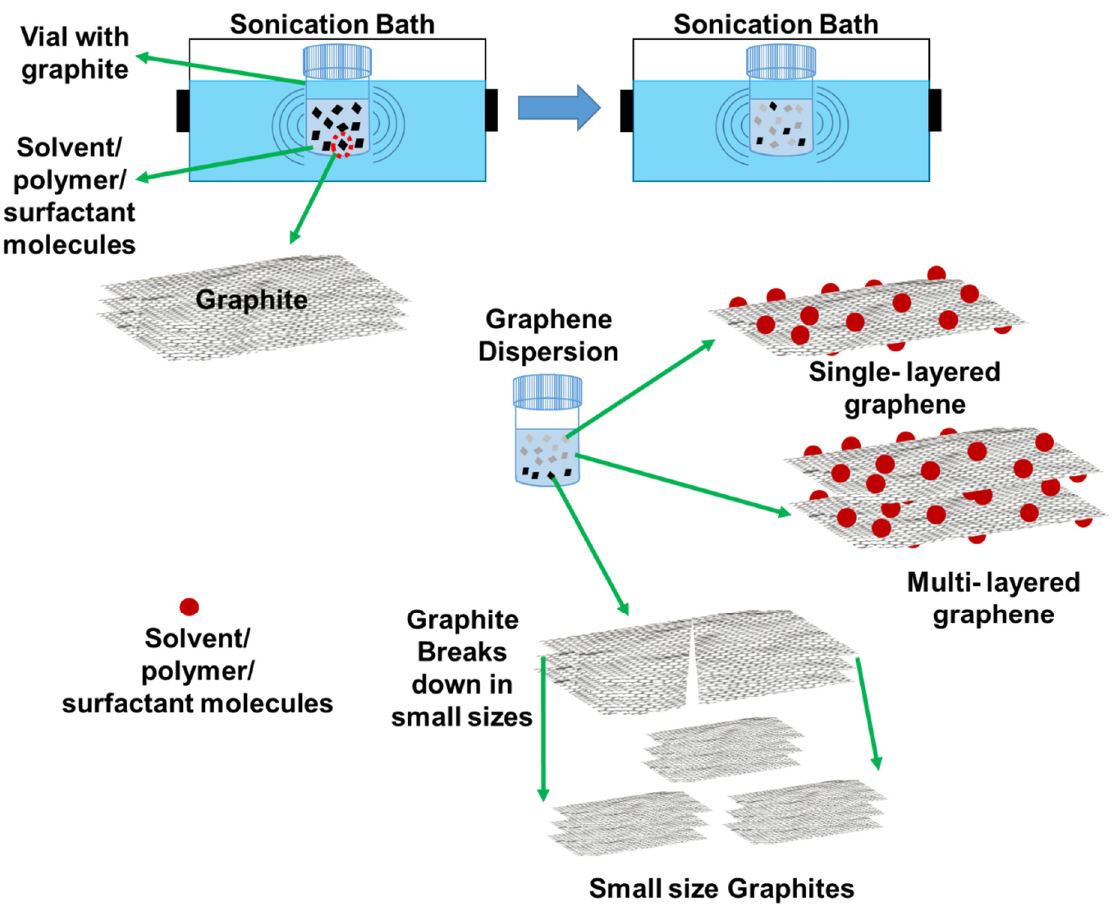
Figure 2. Schematic illustration of the preparation of graphene dispersions using a sonication bath and exfoliation of graphite into graphene. Table 1. A comparison of dispersion methods, graphene sources, solvents, and obtained graphene concentration values.